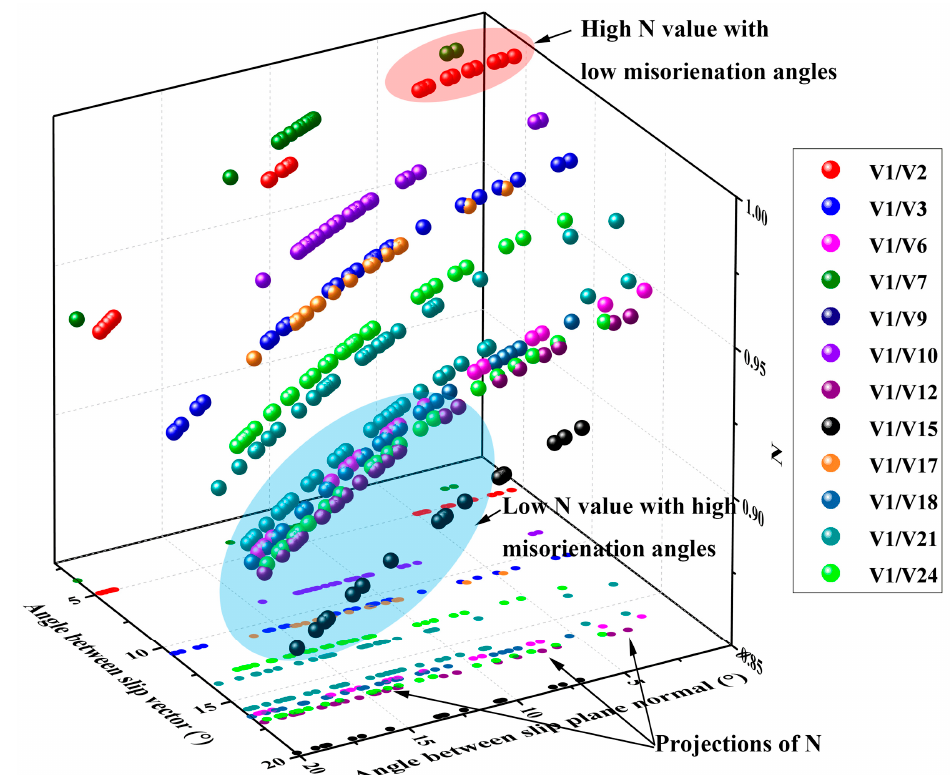
Figure 14. N values of slip systems in the angle range of 0° to 20° between slip plane normal and slip vector.